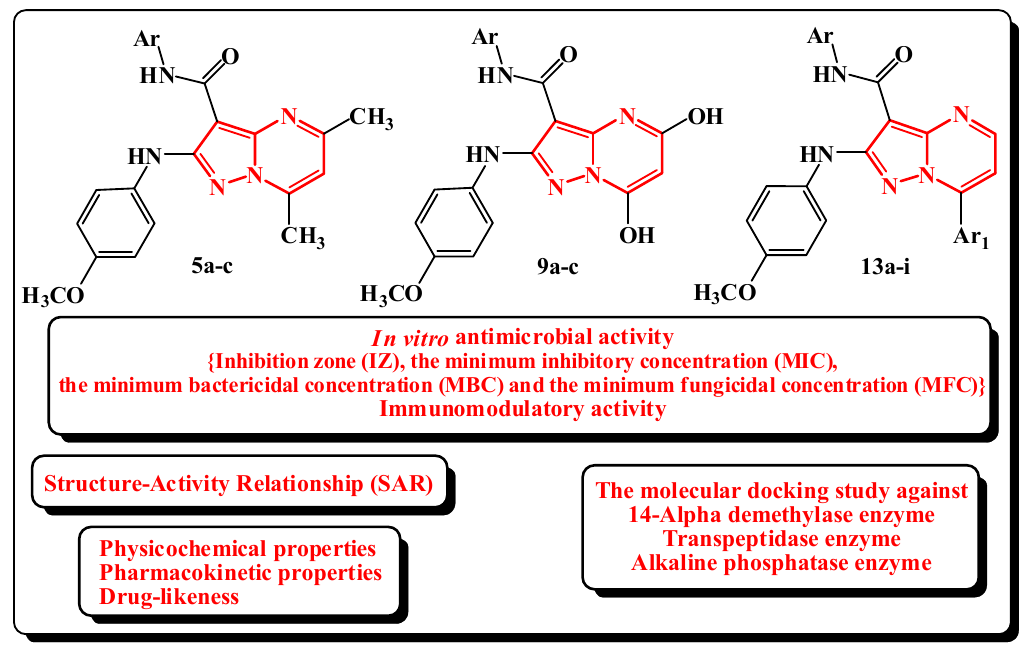
Figure 2. Structure of the target pyrazolo[1,5- a ]pyrimidines ( 5a – c , 9a – c and 13a – i ) and their studies.